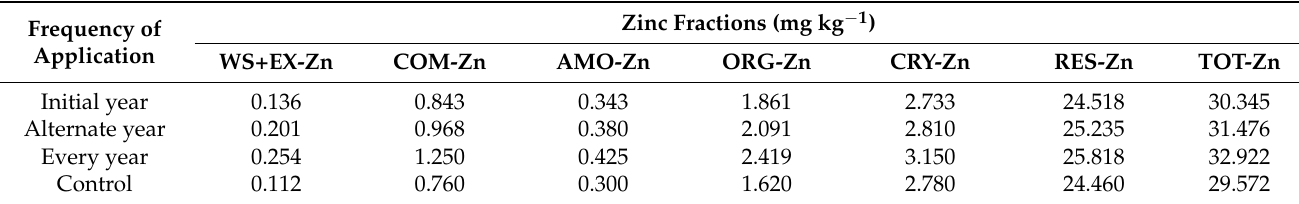
All zinc fractions’ abbreviations are available in Table